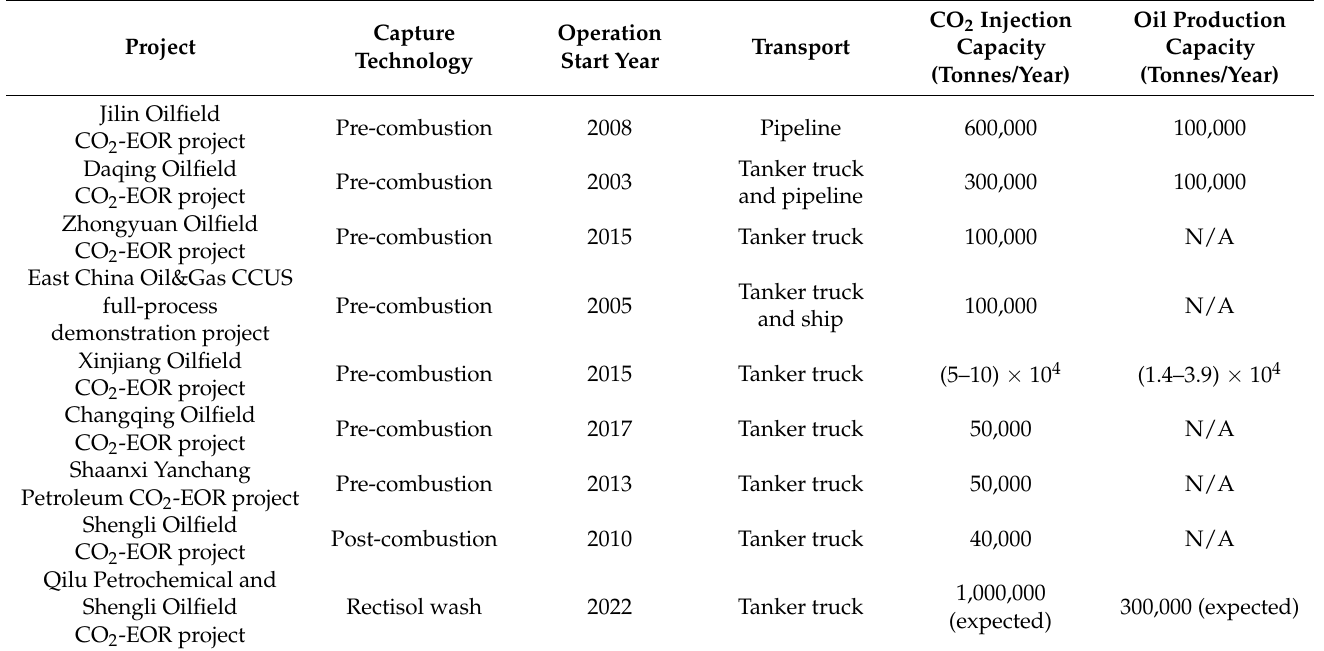
Table 6. CO 2 -EOR projects in China